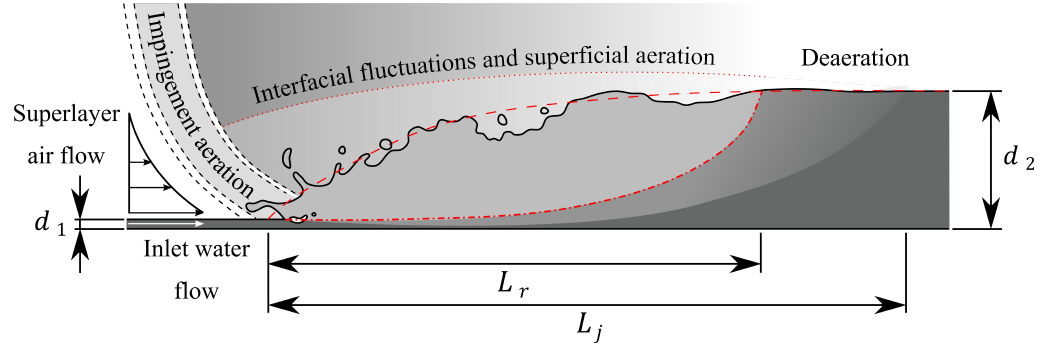
Figure 4. Hydraulic jump flow structure. Sketch of a stable hydraulic jump (see Table